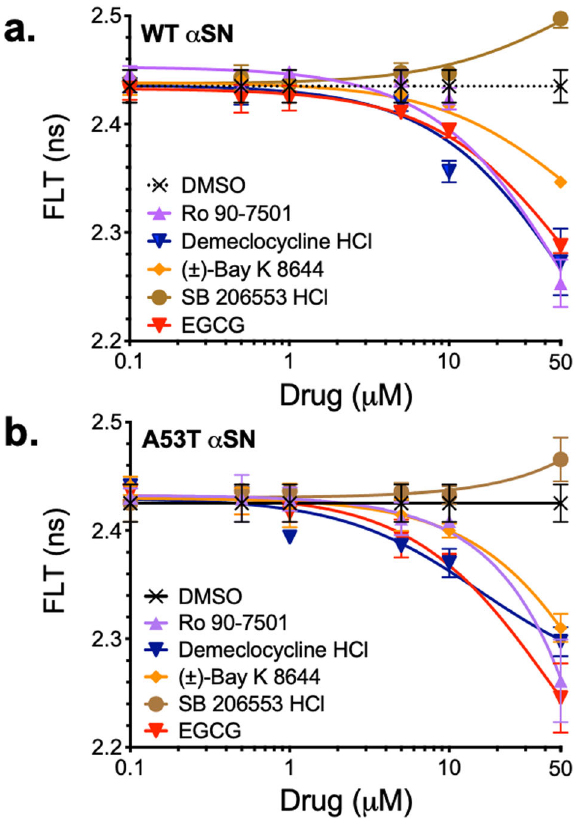
Fig. 6 FRET dose response of pilot HTS hits. A subset of hits were evaluated using both WT ( a ) and A53T ( b ) oligomer biosensor to verify both increased FLT (disrupting α SN – α SN interactions) and decreased FLT (tighter aggregation or remodeled oligomers). Three hits that reduced FLT (RO, BAY, DEM) demonstrated similar response as control EGCG, whereas hit SB206553 demonstrated mild recovery of FLT, suggesting dissociation.